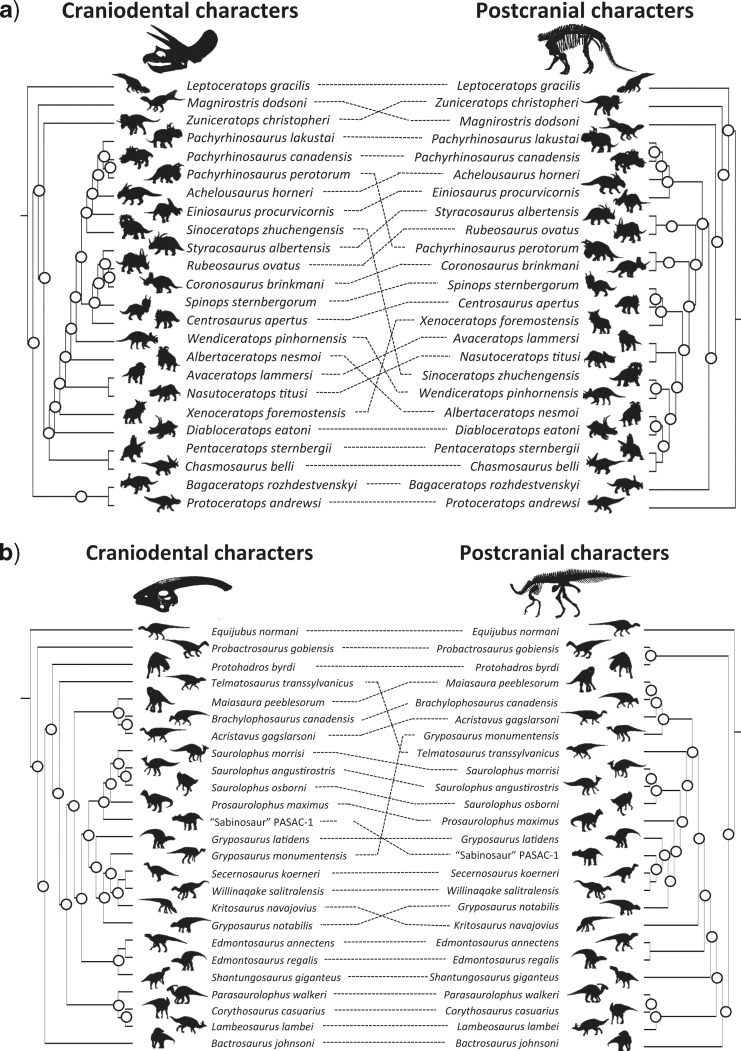
Example tanglegrams for two groups of Ornithischia. All trees are majority rule trees, plus compatible groupings. We do not necessarily recommend the use of majority rule trees in calculating IRD statistics (although we summarize these IRD\documentclass[12pt]{minimal}
\usepackage{amsmath}
\usepackage{wasysym} 
\usepackage{amsfonts} 
\usepackage{amssymb} 
\usepackage{amsbsy}
\usepackage{upgreek}
\usepackage{mathrsfs}
\setlength{\oddsidemargin}{-69pt}
\begin{document}
}{}$_{MR}$\end{document} calculations in Tables 1 and 2), because they can be far from the centroid of tree space (Mounce et al. 2016). Rather, we advocate the use of mean distances between nearest neighbors in the two sets of trees for comparison. The left-hand tree in each panel is derived from craniodental characters, while the right-hand tree is derived from postcranial characters. Circled internal nodes are those present in one tree but not the other, and are tallied to give the RF or symmetrical difference distance (Robinson and Foulds (1981)). a) Tanglegram for Ceratopsia using data from Evans and Ryan (2015). (ILD \documentclass[12pt]{minimal}
\usepackage{amsmath}
\usepackage{wasysym} 
\usepackage{amsfonts} 
\usepackage{amssymb} 
\usepackage{amsbsy}
\usepackage{upgreek}
\usepackage{mathrsfs}
\setlength{\oddsidemargin}{-69pt}
\begin{document}
}{}$P=$\end{document} 0.078; IRD\documentclass[12pt]{minimal}
\usepackage{amsmath}
\usepackage{wasysym} 
\usepackage{amsfonts} 
\usepackage{amssymb} 
\usepackage{amsbsy}
\usepackage{upgreek}
\usepackage{mathrsfs}
\setlength{\oddsidemargin}{-69pt}
\begin{document}
}{}$_{NND+RF} P=$\end{document} 0.04; IRD\documentclass[12pt]{minimal}
\usepackage{amsmath}
\usepackage{wasysym} 
\usepackage{amsfonts} 
\usepackage{amssymb} 
\usepackage{amsbsy}
\usepackage{upgreek}
\usepackage{mathrsfs}
\setlength{\oddsidemargin}{-69pt}
\begin{document}
}{}$_{NND+matching} P=$\end{document} 0.01; IRD\documentclass[12pt]{minimal}
\usepackage{amsmath}
\usepackage{wasysym} 
\usepackage{amsfonts} 
\usepackage{amssymb} 
\usepackage{amsbsy}
\usepackage{upgreek}
\usepackage{mathrsfs}
\setlength{\oddsidemargin}{-69pt}
\begin{document}
}{}$_{MR+RF}$\end{document}\documentclass[12pt]{minimal}
\usepackage{amsmath}
\usepackage{wasysym} 
\usepackage{amsfonts} 
\usepackage{amssymb} 
\usepackage{amsbsy}
\usepackage{upgreek}
\usepackage{mathrsfs}
\setlength{\oddsidemargin}{-69pt}
\begin{document}
}{}$P=$\end{document} 0.03; IRD\documentclass[12pt]{minimal}
\usepackage{amsmath}
\usepackage{wasysym} 
\usepackage{amsfonts} 
\usepackage{amssymb} 
\usepackage{amsbsy}
\usepackage{upgreek}
\usepackage{mathrsfs}
\setlength{\oddsidemargin}{-69pt}
\begin{document}
}{}$_{MR+matching} P=$\end{document} 0.01). b) Tanglegram for Hadrosaurida using data from Prieto-Marquez (2014). (ILD \documentclass[12pt]{minimal}
\usepackage{amsmath}
\usepackage{wasysym} 
\usepackage{amsfonts} 
\usepackage{amssymb} 
\usepackage{amsbsy}
\usepackage{upgreek}
\usepackage{mathrsfs}
\setlength{\oddsidemargin}{-69pt}
\begin{document}
}{}$P=$\end{document} 0.088; IRD\documentclass[12pt]{minimal}
\usepackage{amsmath}
\usepackage{wasysym} 
\usepackage{amsfonts} 
\usepackage{amssymb} 
\usepackage{amsbsy}
\usepackage{upgreek}
\usepackage{mathrsfs}
\setlength{\oddsidemargin}{-69pt}
\begin{document}
}{}$_{NND+RF} P=$\end{document} 0.34; IRD\documentclass[12pt]{minimal}
\usepackage{amsmath}
\usepackage{wasysym} 
\usepackage{amsfonts} 
\usepackage{amssymb} 
\usepackage{amsbsy}
\usepackage{upgreek}
\usepackage{mathrsfs}
\setlength{\oddsidemargin}{-69pt}
\begin{document}
}{}$_{NND+matching} P=$\end{document} 0.12; IRD\documentclass[12pt]{minimal}
\usepackage{amsmath}
\usepackage{wasysym} 
\usepackage{amsfonts} 
\usepackage{amssymb} 
\usepackage{amsbsy}
\usepackage{upgreek}
\usepackage{mathrsfs}
\setlength{\oddsidemargin}{-69pt}
\begin{document}
}{}$_{MR+RF} P=$\end{document} 0.83; IRD\documentclass[12pt]{minimal}
\usepackage{amsmath}
\usepackage{wasysym} 
\usepackage{amsfonts} 
\usepackage{amssymb} 
\usepackage{amsbsy}
\usepackage{upgreek}
\usepackage{mathrsfs}
\setlength{\oddsidemargin}{-69pt}
\begin{document}
}{}$_{MR+matching} P=$\end{document} 0.37). All silhouettes are original drawings by Yimeng Li.